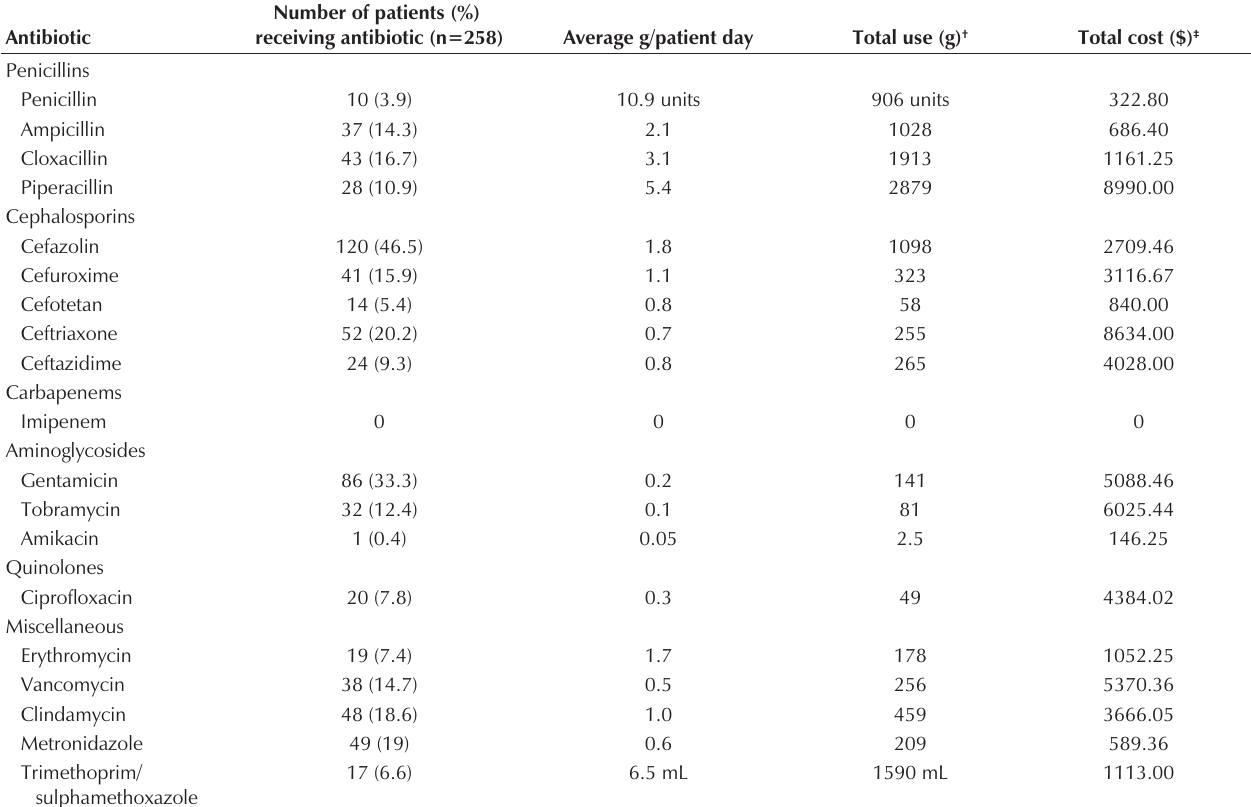
Parenteral antibiotic usage in the critical care unit at Sunnybrook Health Science Centre, Toronto, Ontario from May 1, 1995 to April 30, 1996*